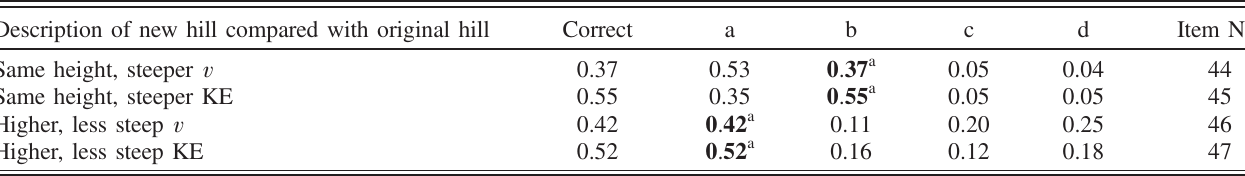
TABLE X. Response rates for energy